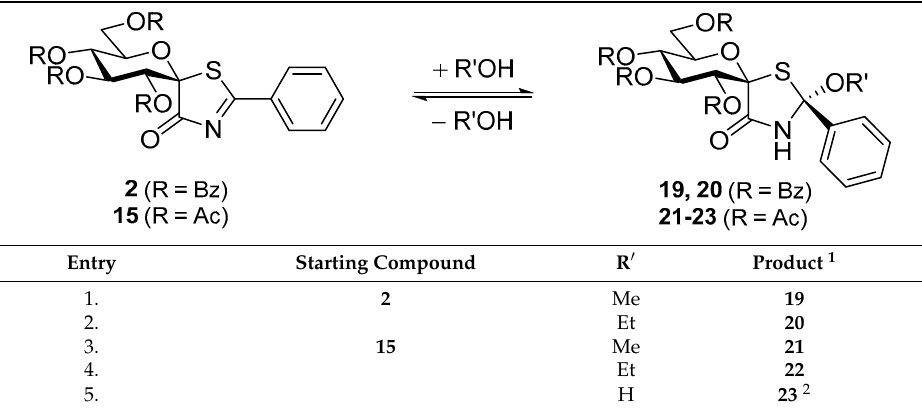
Table 3. Addition of alcohols and water onto spiro-thiazolinones 2 and 15